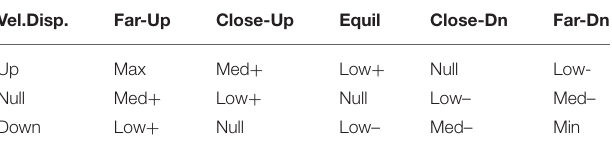
TABLE 1 | Fuzzy inference system rules. Vel.Disp.